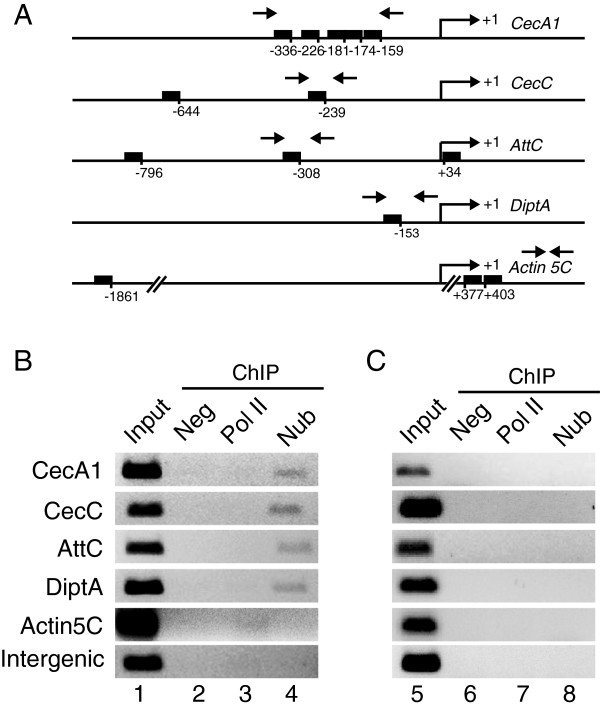
Nub binds to the upstream region of several antimicrobial peptide genes. (A) Promoter regions of CecA1, CecC, Dipt, AttC and Act5C, in which Oct and Oct-like-binding site(s) are represented by black boxes. The numbers below each box represents the position of the binding site in correlation to the transcriptional start site. The arrows indicate the forward and reverse primers. In the Act5C gene, two Oct-binding sites are located in the first intron, while the primers bind to a region in the second intron. (B) Chromatin was extracted from whole OrR flies after fixation with formaldehyde and immunoprecipitation reactions were carried out with a peptide-specific Nub antibody (lane 4). Negative control immunoprecipitations were carried out in parallel, either without antibody (lane 2) or with an antibody against the C-terminal domain of RNA polymerase II (lane 3), which is not expected to bind to the upstream region of these genes in uninfected flies. Primers located in the transcribed region of Act5C gene and in a non-transcribed region (intergenic region) were analyzed in parallel to assess the specificity of the chromatin immunoprecipitation, showing that RNA polymerase II, but not Nub, binds to the transcribed region of the Act5C gene, while neither protein binds to the non-transcribed region. (C) Control immunoprecipitation with chromatin, which was phenol-chloroform-extracted prior to fixation, showing the specificity of the protein-antibody interactions. As expected, no PCR products were observed with any of the antibodies.